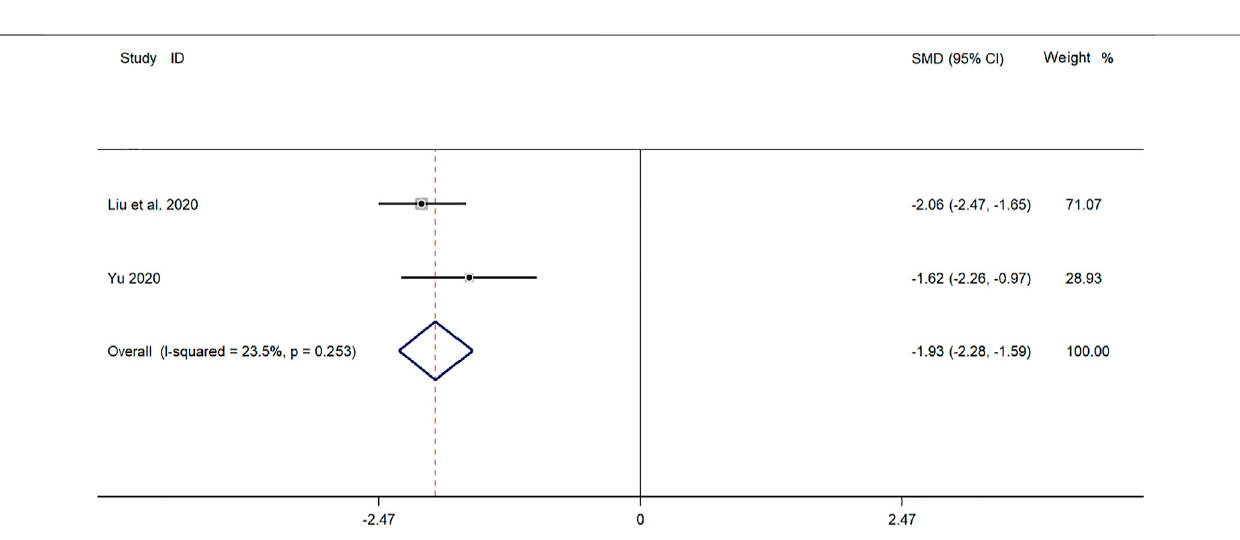
Frontiers in Pharmacology |